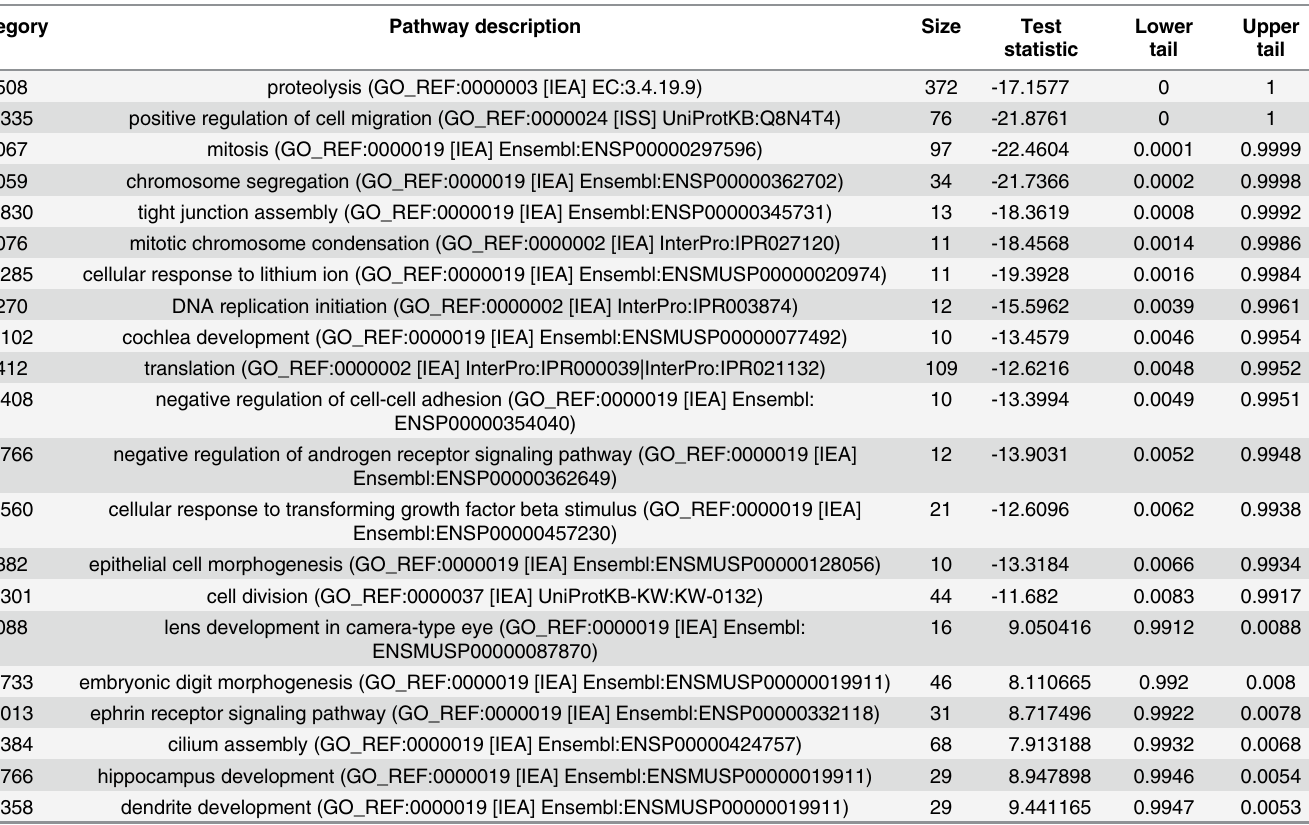
Lower and Upper tail values show the mass in the permutation based p-value distribution below or above the value of the test statistic. P values represented as 0 are less than 10 -16